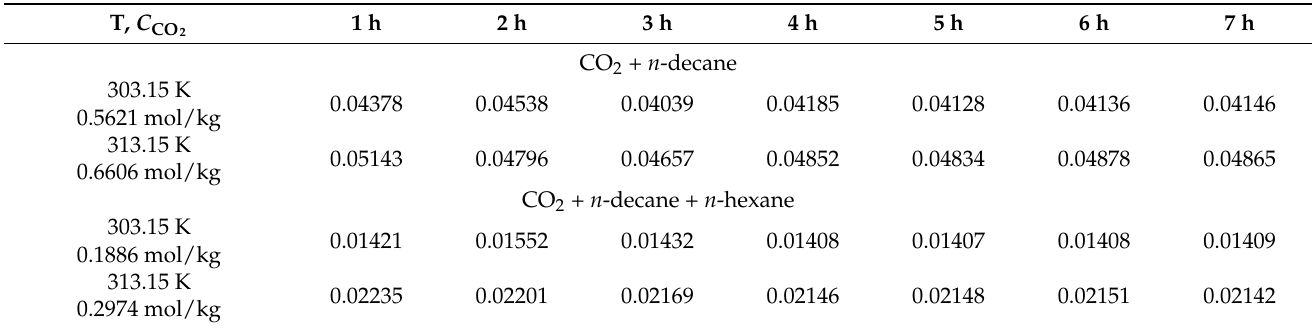
Table 1. The Raman peak intensity ratio of mixture at different time.